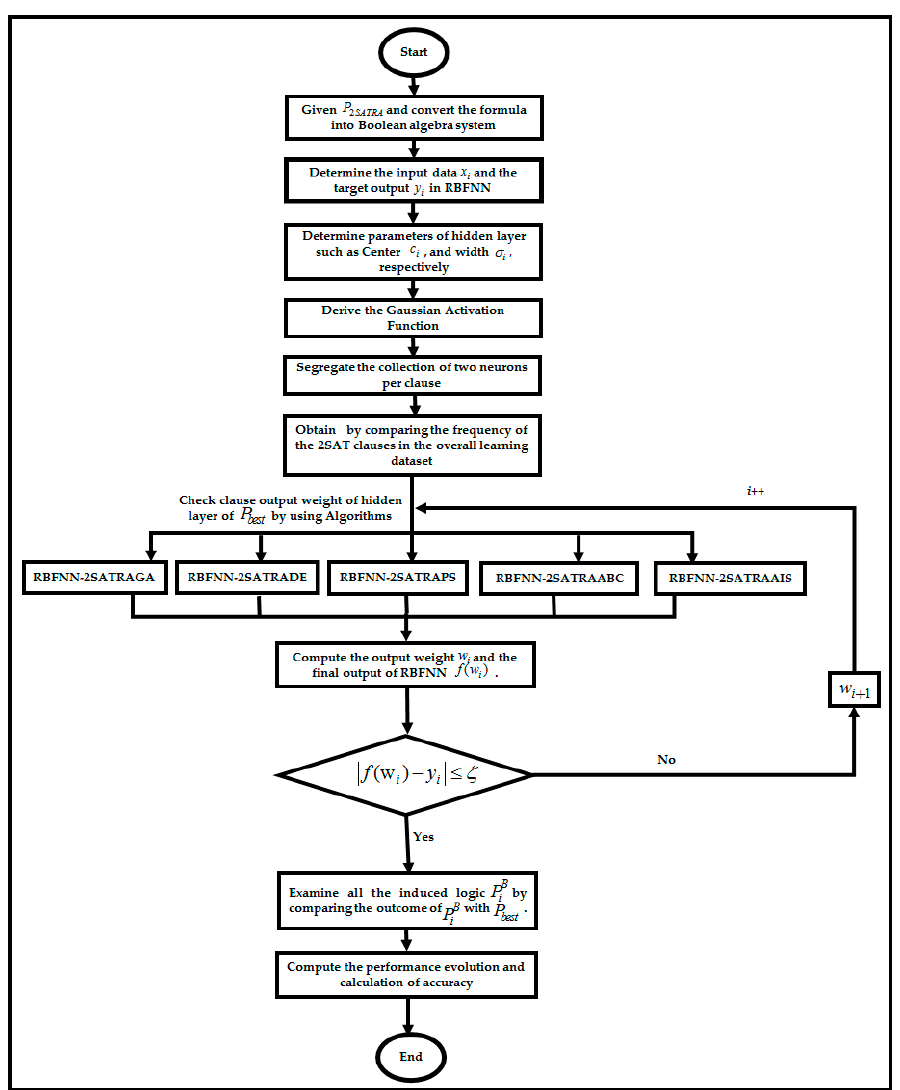
Figure 2. Flowchart of the methodology.